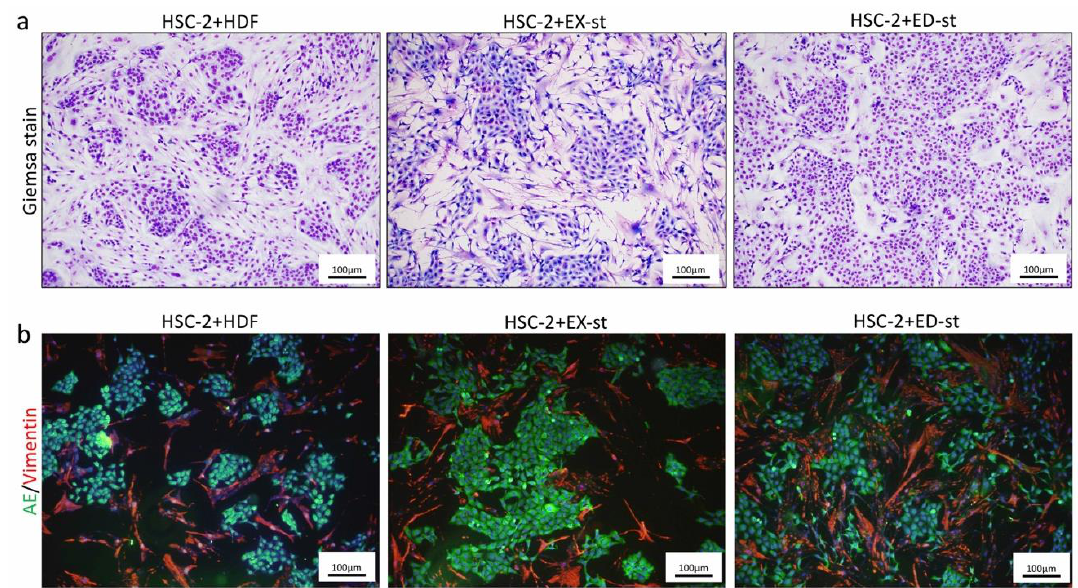
Figure 4. Representative images and immunofluorescent staining of 2D co-culture with HSC-2 cells and various types of stroma. ( a ) In the HSC-2/HDF co-culture group, cancer cells forming very small masses were observed. In the HSC-2/EX-st co-culture group, large cancer nests were observed. In the HSC-2/ED-st co-culture group, relatively small cancer nests were formed. ( b ) Immunofluorescent staining with vimentin (red) and AE1/3 (green) and DAPI counterstaining (blue). In the HSC-2/HDF co-culture group, a small number of small tumor nests with weak adhesion between tumor cells was observed, and the growth of the tumor stroma was also loose. In the HSC-s/EX-st group, tumor cells formed large tumor nests, the stromal cells showed dendritic or spindle-shaped morphology, and the stroma showed dense growth in some areas. In the HSC-s/ED-st group, vigorous growth of small tumor nests was observed, and dense dendritic tumor stromal cells were observed.